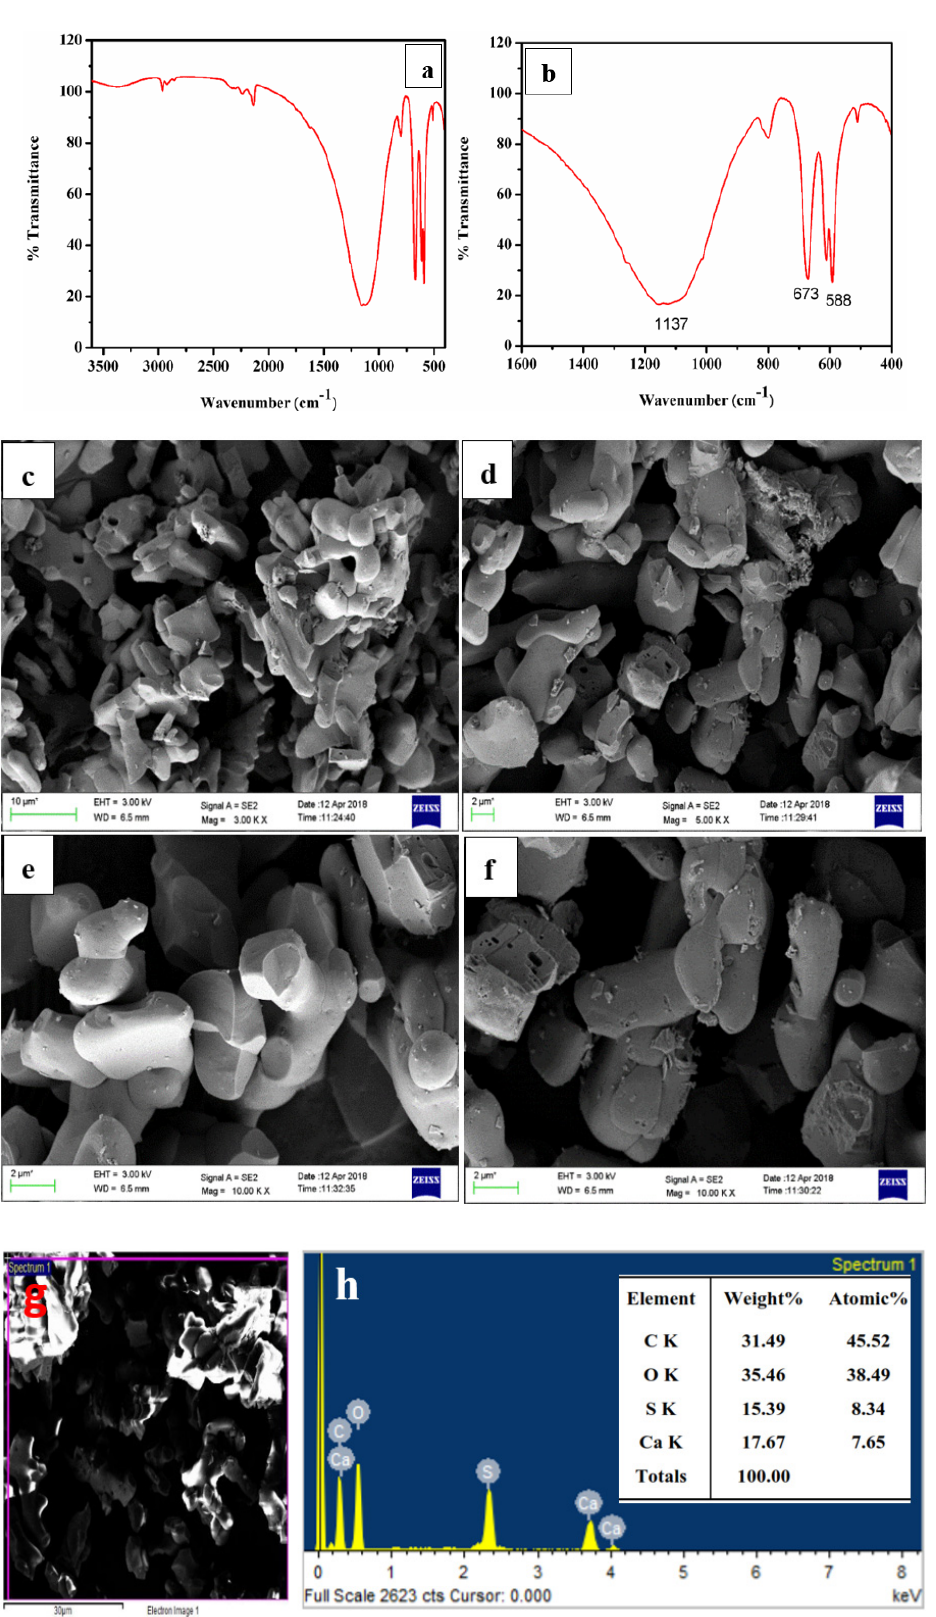
Figure 9. ( a , b ) FTIR and deconvoluted, respectively.; ( c – f ) FESEM images; ( g ) EDS spot; ( h ) EDS spectra.